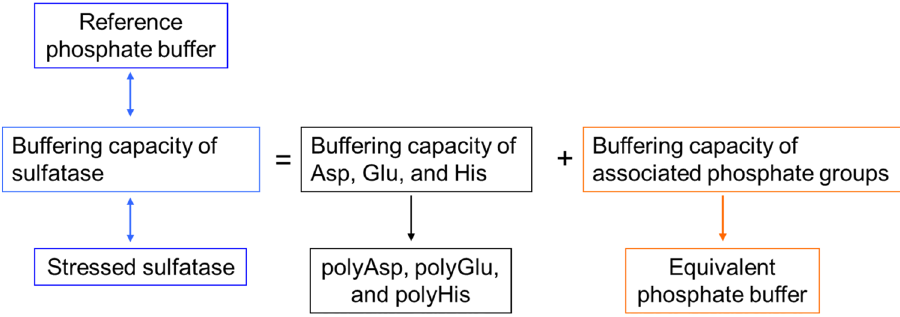
Figure 1. Schematic of study